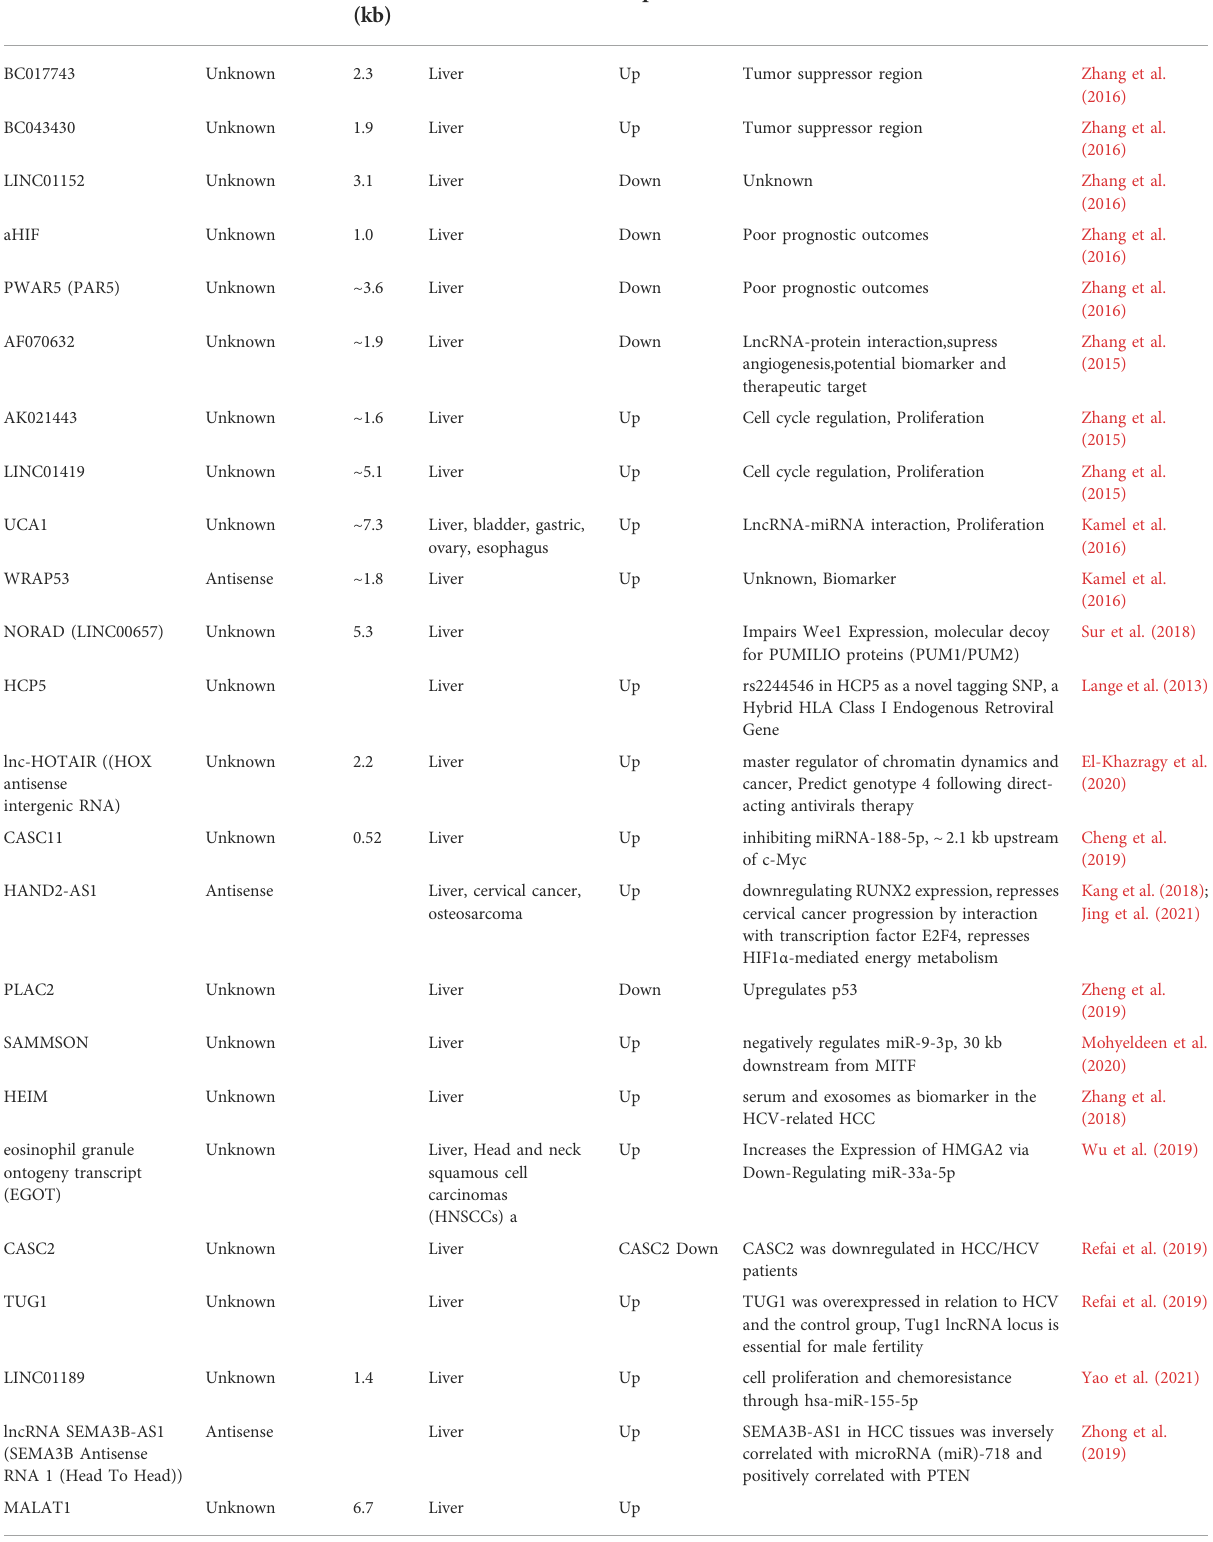
TABLE 1 LncRNAs linked to HCV-associated